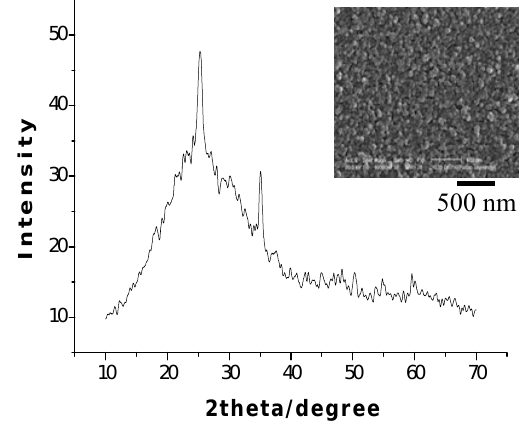
film prepared by anodic electrodeposition. Inset shows the 2 2